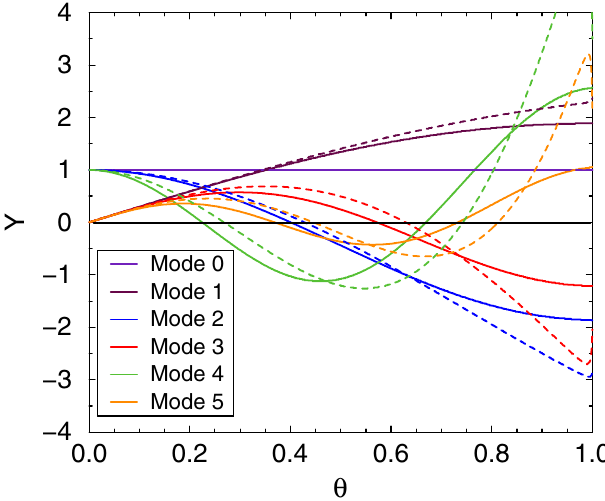
FIG. 4. (Color) Eigenfunctions of the ‘‘superparabolic’’ bunch. Solid lines: (cid:7) ¼ 0 : 05 ; dashed ones: (cid:7) ¼ 1